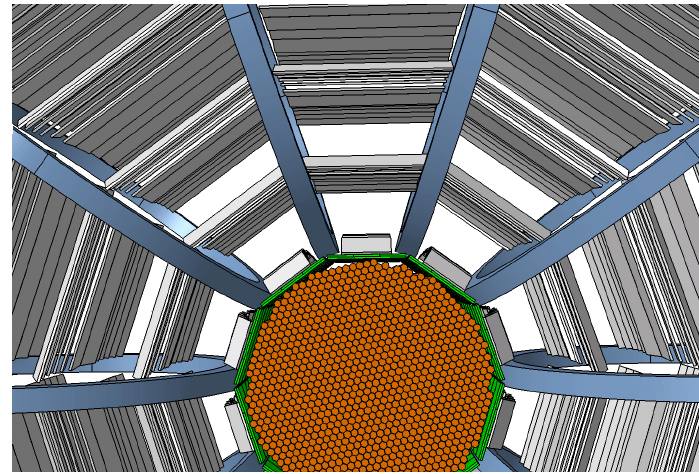
Figure 13. Detailed rendering of the front view of the ALADInO calorimeter (orange) placed in the center of the